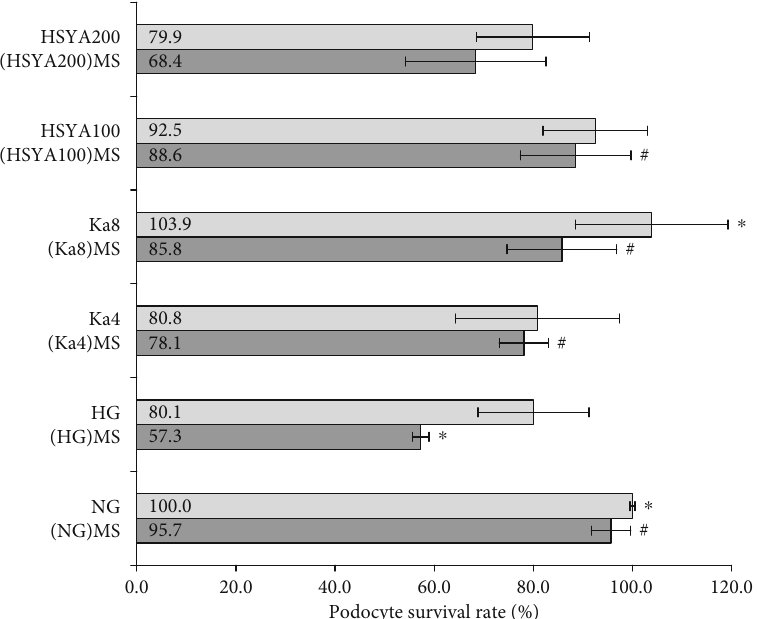
Figure 6: Determination of cell survival rate of podocytes. Values were expressed as mean ± standard errorof themean ( n = 6 ). ∗ p < 0 : 05 versus HG. # p < 0 : 05 versus (HG) MS. Abbreviations: NG: 11.1 mM glucose; HG: 33.3mM glucose; Ka4: kaempferol 4 μ M in HG; Ka8: kaempferol 8 μ M in HG; HSYA100: hydroxysa ffl or yellow A 100 μ M in HG; HSYA200: hydroxysa ffl or yellow A 200 μ M in HG; (NG) MS: the supernatants from NG-cultured macrophage; (HG) MS: the supernatants from HG-cultured macrophage; (Ka4) MS: the supernatants from kaempferol 4 μ M and HG-cultured macrophage; (Ka8) MS: the supernatants from kaempferol 8 μ M and HG-cultured macrophage; (HSYA100) MS: the supernatants from hydroxysa ffl or yellow A 100 μ M and HG-cultured macrophage; (HSYA200) MS: the supernatants from hydroxysa ffl or yellow A 200 μ M and HG-cultured